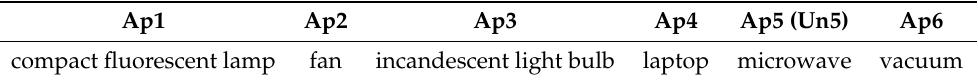
Table 3. The list of appliances in the Plug-Level Appliance Identification Dataset (PLAID) dataset.